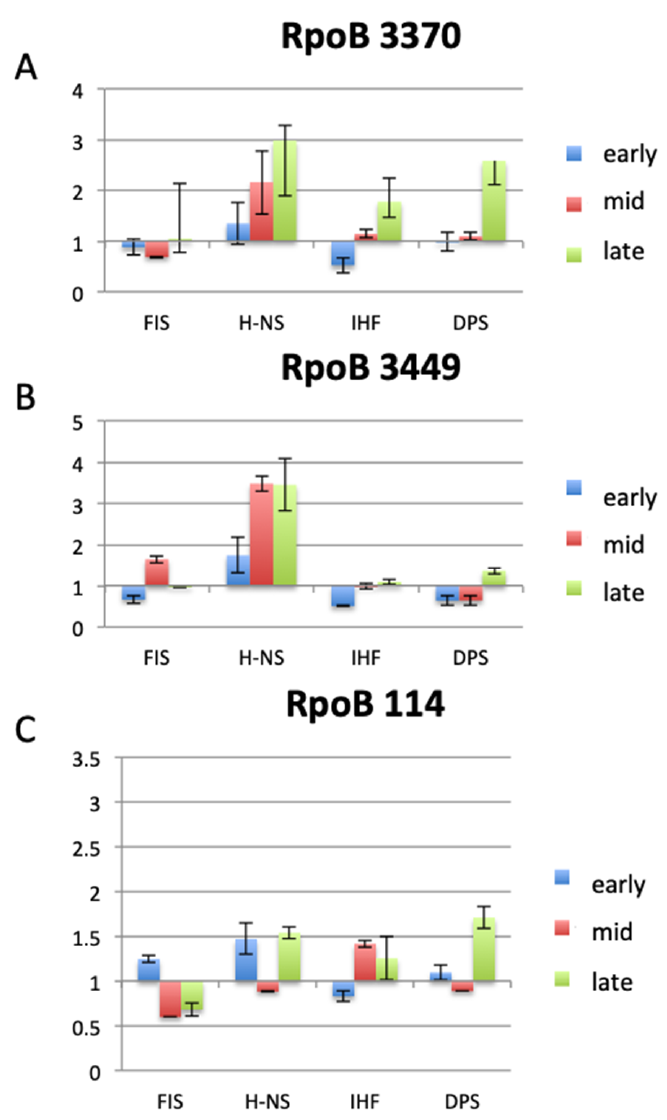
Figure 3. Variation of the NAP levels in E. coli CSH50 cells carrying mutations in the beta subunit of RNAP (“stringent” RNAP mutants; described in [97]), during the various growth stages. Western blots of FIS, H-NS, IHF and Dps proteins in crude protein extracts of: ( A ) rpoB3370 (T563P), ( B ) rpoB3449 (D532A) and ( C ) rpoB114 (S531F) strains analyzed during early (exponential), middle (transition to stationary) and late (stationary) growth phases. Overnight cultures (after 12 h of growth in a shaker at 37 ◦ C) were inoculated in rich dYT medium at O.D 600 of 0.1. The cultures were grown in a fermenter under constant pH 7.4 and high aeration (5 L air per min) at 37 ◦ C. The cells were harvested during exponential phase at O.D 600 of 0.5 (early), at O.D 600 of 2.0 during transition to stationary phase (mid) and at O.D 600 of 4.0 in stationary phase (late). The relative NAP amounts in the “stringent” RNAP mutants were normalized to those in the wild type cells. NAP proteins were detected using mouse monoclonal antibodies raised against FIS, H-NS, IHF and Dps. Bars indicate the standard errors of two biological replicates (for experimental details, see the appended Master Thesis of Steffi Jimmy in the Supplementary data file). Table 2. Impacts of NAPs/global TFs and the RNAP sigma factors in the transcript profiles of growing cells (data from ref. [39]). The first two columns compare the relative impacts in the profiles of wild-type and rpoZ mutants, the next two columns compare those in rpoZ mutant with and without rpoD overexpression.